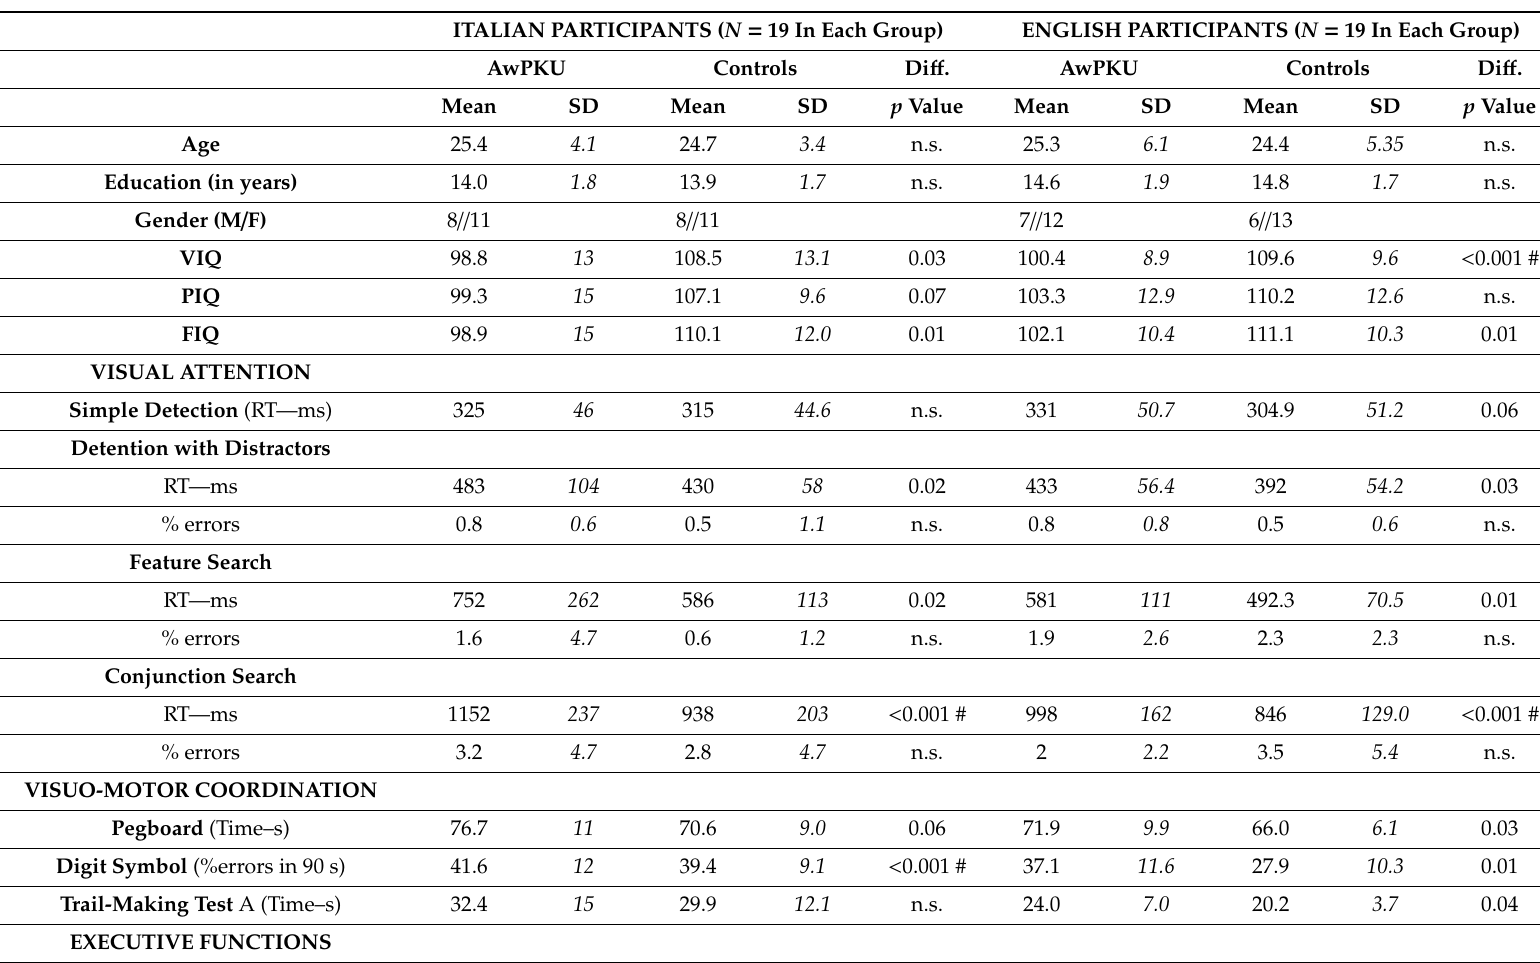
Table 2. Cognitive Performance of Italian and English PKU Participants and Healthy Controls Matched for Age and Educations to the Respective Clinical Groups. ITALIAN PARTICIPANTS ( N = 19 In Each Group) ENGLISH PARTICIPANTS ( N = 19 In Each Group)